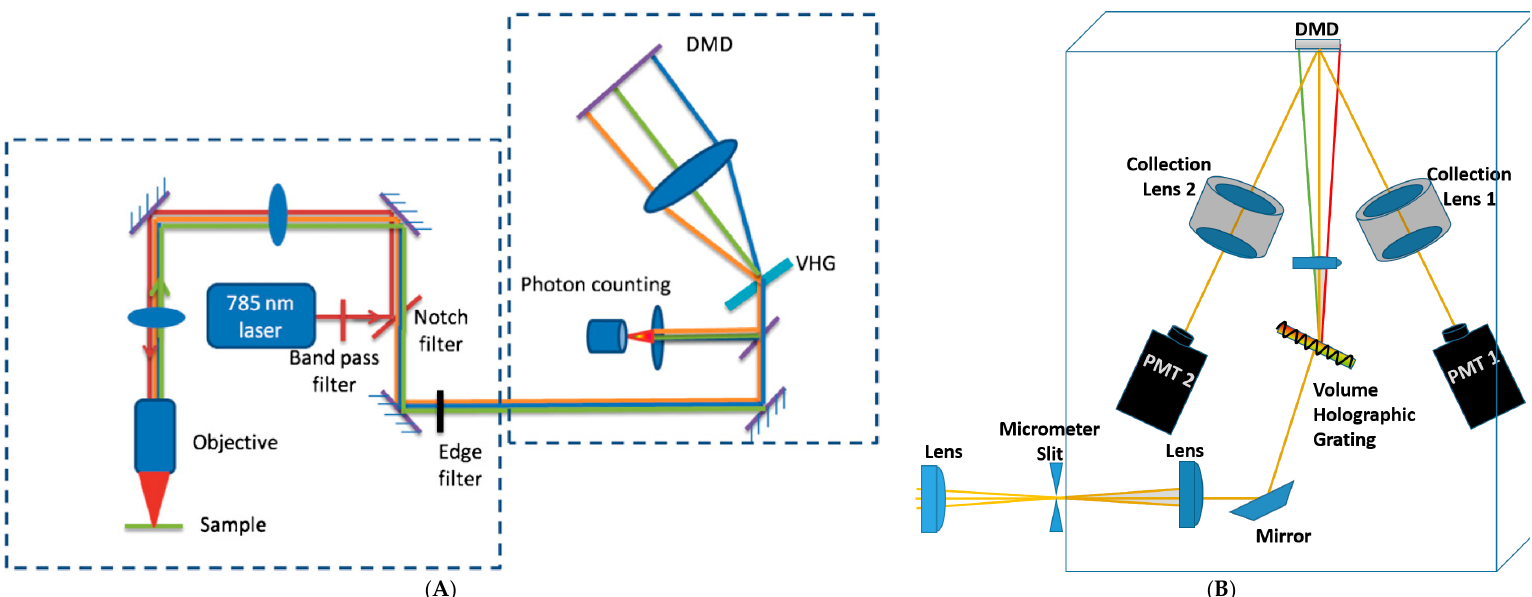
Figure 1. ( A ) Schematic of optimized binary compressive detection (OBCD) Raman system with 785 nm laser source (Reprinted from Reference [1] with permission from Elsevier); ( B ) schematic of Dual Detector CD (OBCD2) (detection module is shown only). Collimated beam of light is focused on a slit at the entrance of the spectrometer. The beam is recollimated and dispersed using a volume holographic grating (VHG). The dispersed beam is focused onto the DMD. The DMD can send parts of all the light towards either detector.